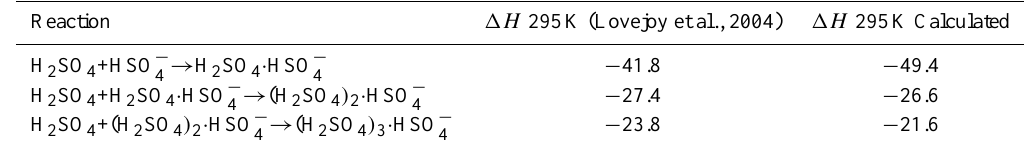
Table 1. Enthalpy changes 1H (in units of kcal/mol); comparison between experimental and calculated values. Reaction